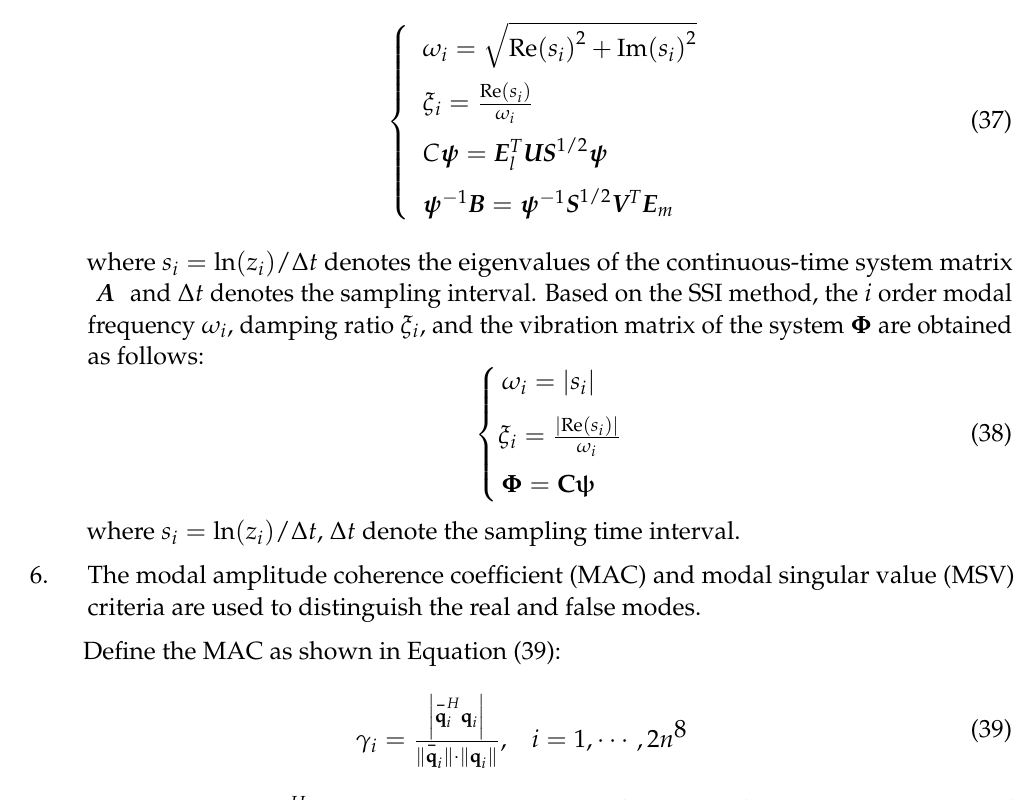
5. The information of the modal parameters is extracted from the system matrix. Based on the solutions of vibration theory and state equation, the i order modal frequency